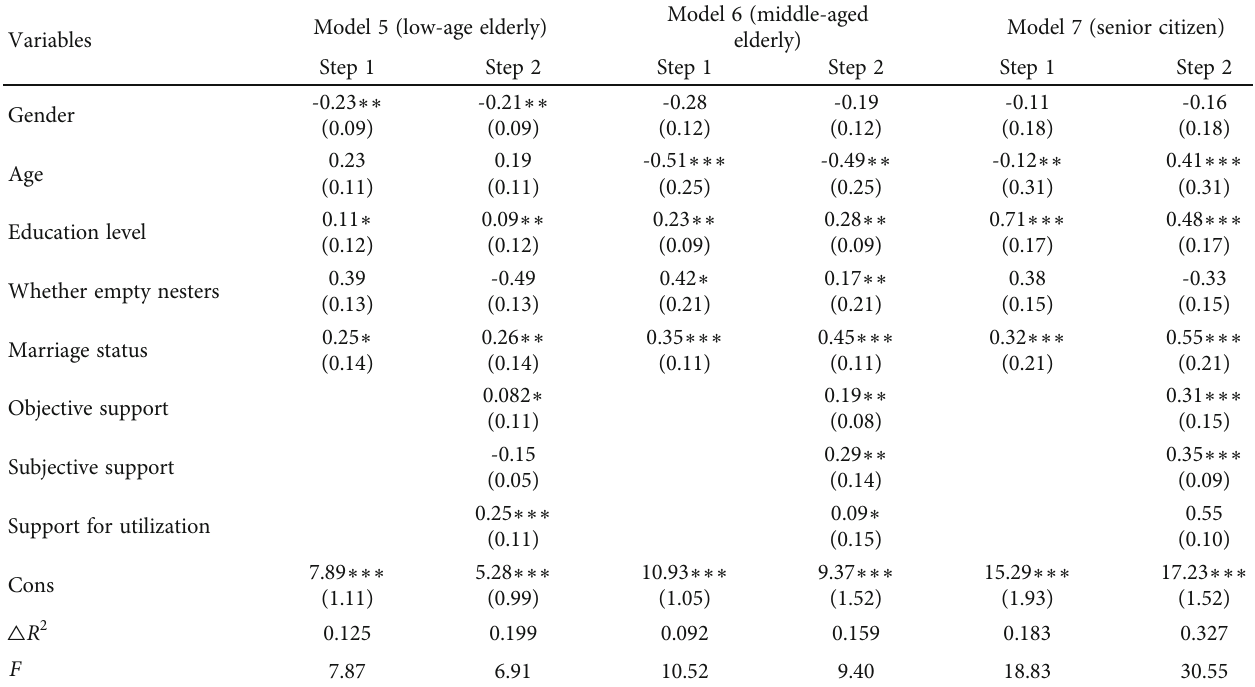
Table 4: E ff ect of social support on the health of older adults in di ff erent age